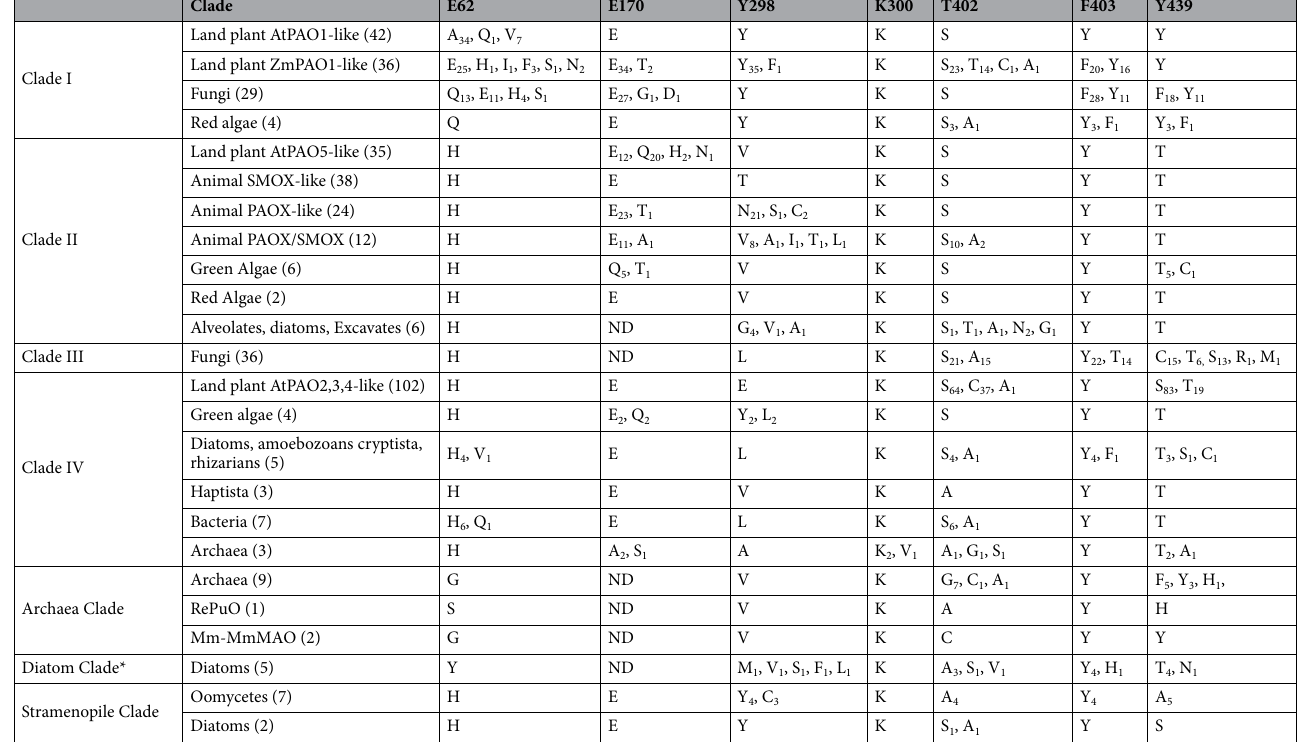
Table 1. Amino acid residues of the catalytic site of the various PAOs. Amino acid numbering refers to ZmPAO1 mature protein 35 . Numbers in parentheses indicate the number of PAOs analyzed. Subscript numbers indicate the number of PAOs sequence with each amino acid residue at the corresponding position. ND: not determined, due to the presence of gaps and regions of low sequence homology. *SD-To1,2,3 and